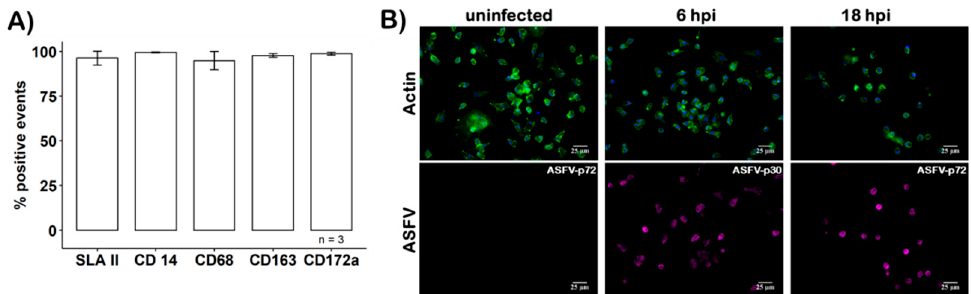
Figure 2. Characterization of moM Φ . ( A ) Phenotypic characterization of moM Φ by flow cytometry. Surface markers SLA class II, CD14, CD68, CD163 and CD172a are expressed on >95% of all moM Φ . ( B ) Morphologic characterization by fluorescence microscopy. Representative data from different preparations are shown. moM Φ were infected with ASFV at MOI2, fixed at 6 or 18 hpi, and stained for actin with phalloidin (green) to visualize the cell cortex. Early (p30, 6 hpi) or late (p72, 18 hpi) ASFV proteins were immunostained (violet) with appropriate antibodies. Bar indicates 25 μ m.